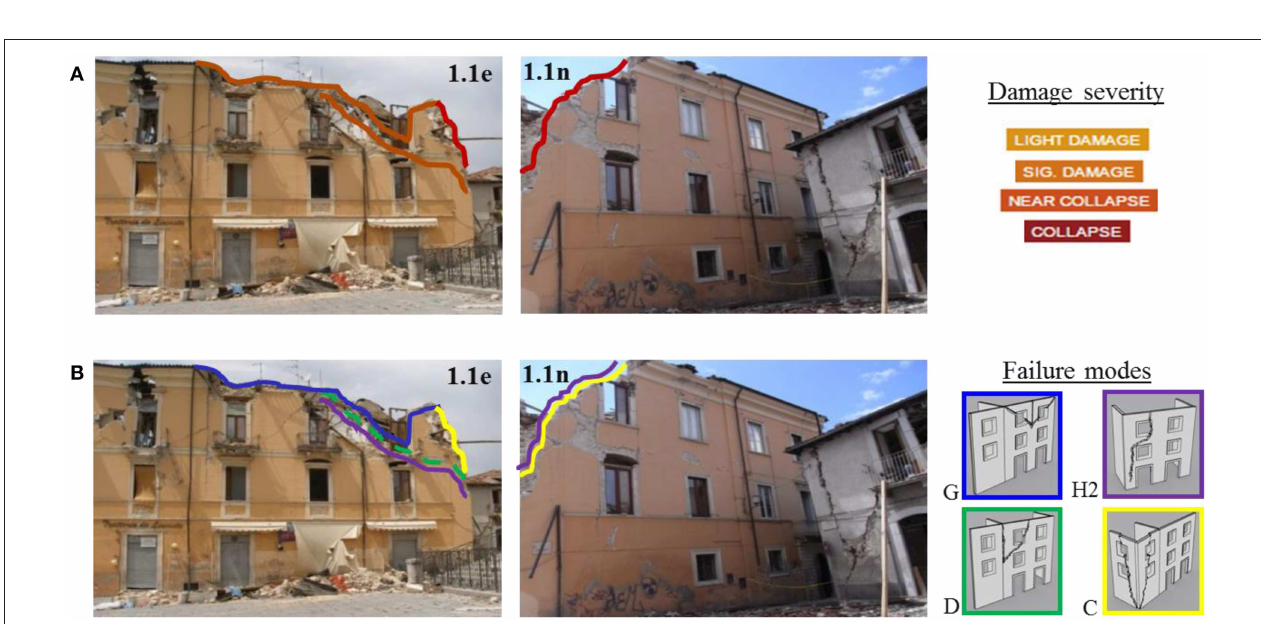
FIGURE 9 | (A) Damage severity; and (B) failure modes attributed on site to building 1.1 by trained engineers.